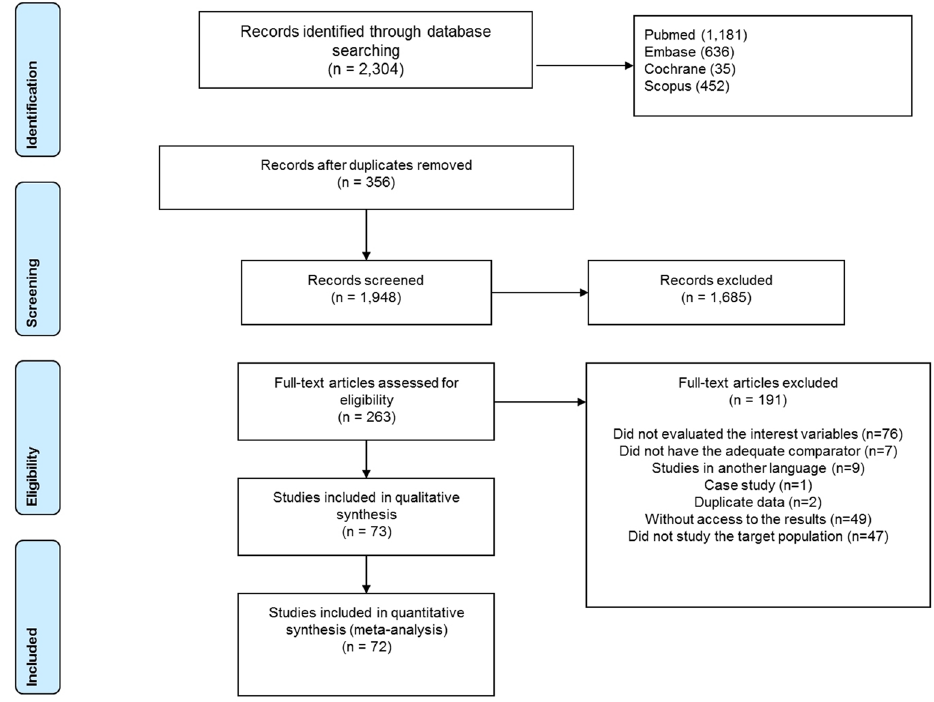
Figure 1. Flowchart of number of articles retrieved during the literature search and study